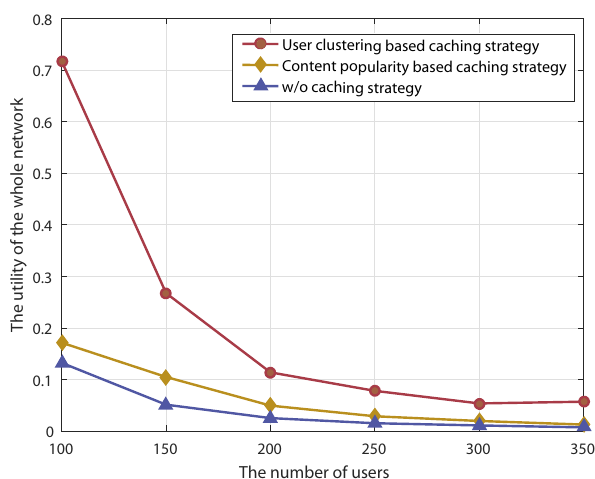
Figure 4. The utility of the whole network for different UAV caching